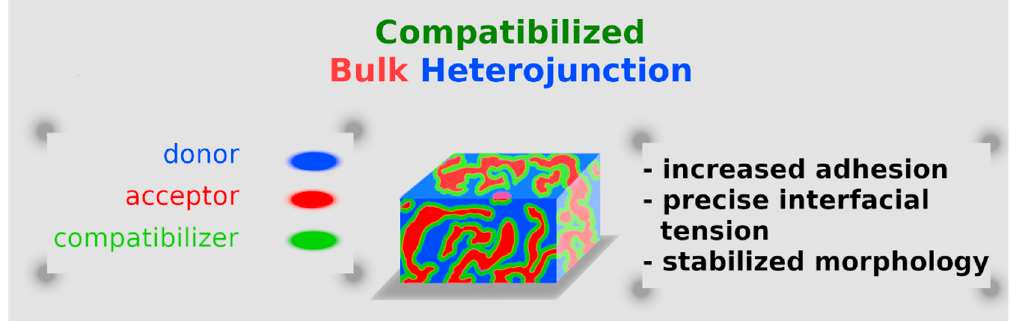
Figure 2. Pictorial description of a compatibilized Bulk Heterojunction (BHJ). The role of the compatibilizers (CBs) in the field of organic photovoltaics broadly matches the definition of compatibilizer in polymer chemistry.